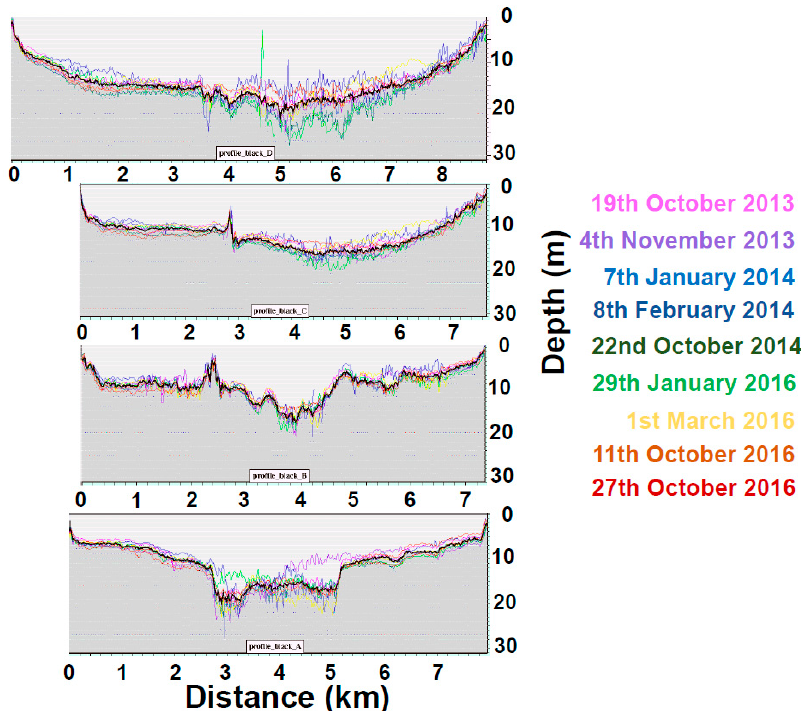
Figure 3. Plot of the depth combination process along four profiles across the SLC. All profiles run from North to South. Thick black profiles are combined depths.